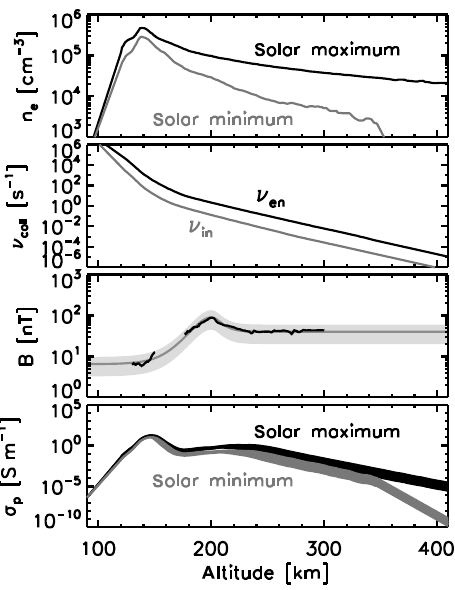
Figure 1. Electron number density n e from Pioneer Venus Orbiter radio occultation measurement after Kilore and Luhmann (1991), model collision frequency between electrons and neutral particles ν en and that between ions and neutral particles ν in after Dubinin et al. (2014), magnetic field B after Venus Express measurements in black (after Villarreal et al., 2015 and Zhang et al., 2016) and model magnetic field with a fluctuation range (in gray), and Peder- sen conductivity σ p as a function of altitude from Venus’